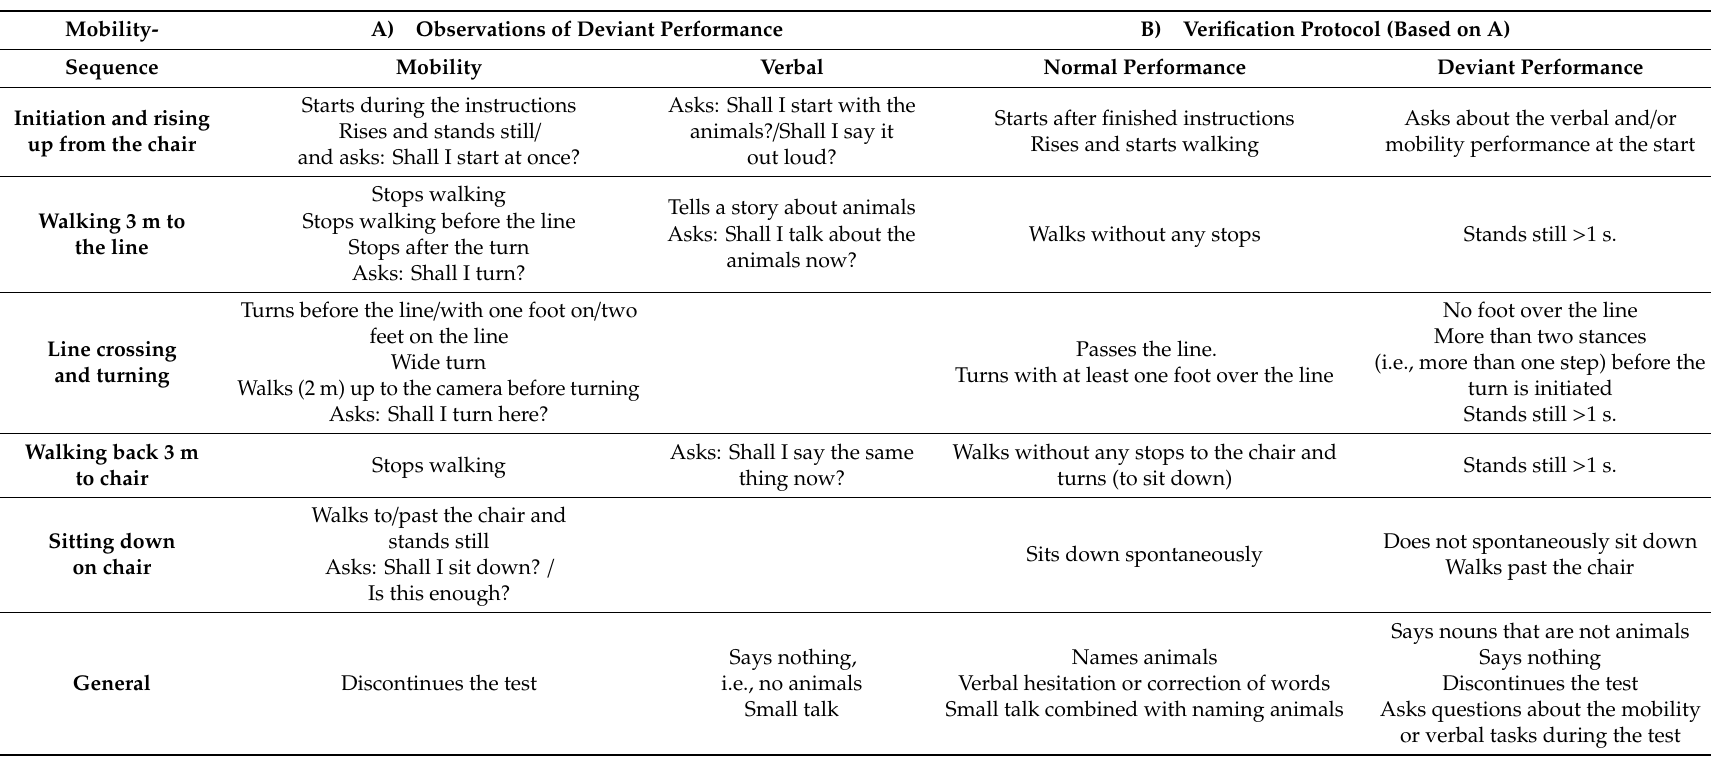
Table 2. Overview of results from qualitative analysis of video recorded Timed Up-and-Go dual task test performances and the verification protocol developed through interpretation of these